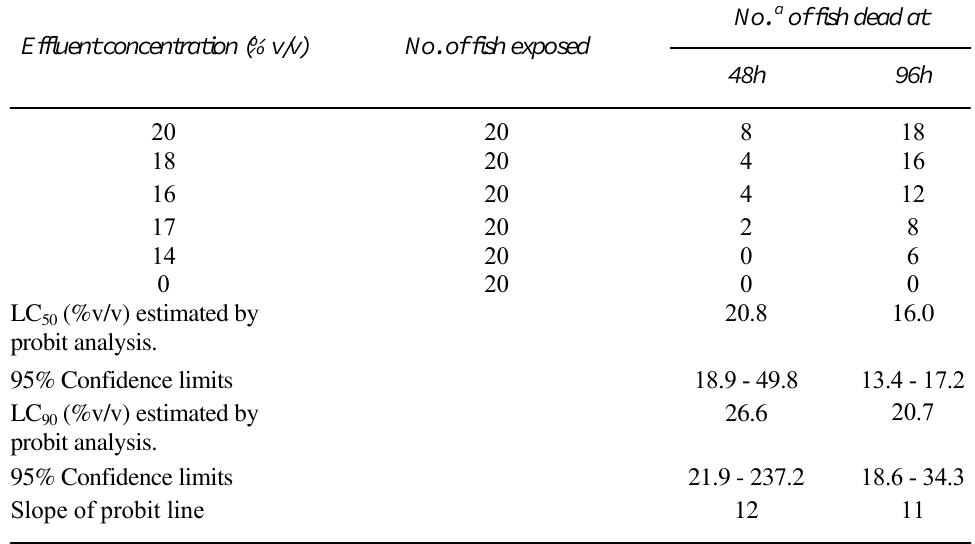
Table 2: Experimental data from the acute toxicity test of Pilcam effluent on fish ( Oreochromis